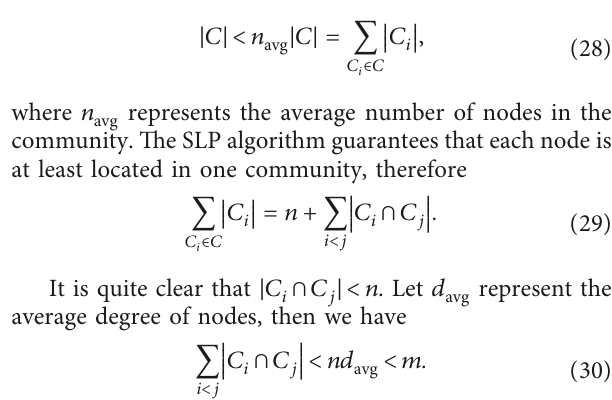
Figure 6: Interaction frequency between node i and j in a sliding window of size 10 time